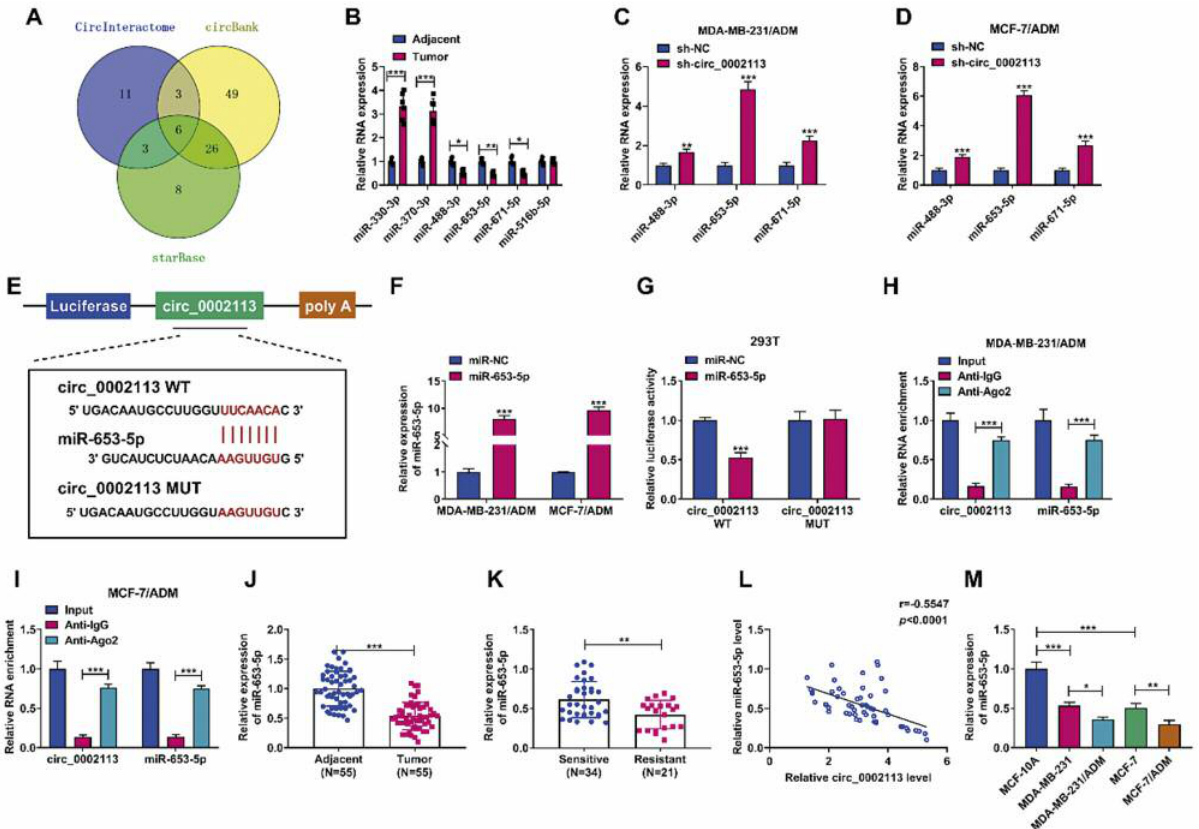
Fig. 4. Circ_0002113 interaction with miR-653-5p was a ffi rmed in BC. (A) Venn diagram analysis of miRNA targets for circ_0002113 from circinteractome, circBank and starBase. (B) The levels of miR-330-3p, miR-370-3p, miR-488-3p, miR-653-5p, miR-671-5p, miR- 516b-5p in BC tissues were detected by RT-qPCR. (C) The level analysis of miR-488-3p, miR-653-5p and miR-671-5p was conducted by RT-qPCR after transfection of sh-NC or sh-circ_0002113. (E) Circ_0002113 with miR-653-5p binding sites in circinteractome. (F) Overexpression e ffi ciency of miR-653-5p was evaluated using RT-qPCR in MDA-MB-231/ADM and MCF-7/ADM cells. (G-I) Dual- luciferase reporter assay (G) and RIP assay (H-I) were performed to analyze the binding between circ_0002113 and miR-653-5p. (J- K) The level of miR-653-5p by RT-qPCR in BC/normal tissues (J) and ADM-sensitive/resistant BC tissues (K). (L) The relation between circ_0002113 and miR-653-5p by Pearson’s correlation coe ffi cient in BC tissues. (M) RT-qPCR was used to examine miR-653-5p ex- pression in MDA-MB-231/ADM, MCF-7/ADM cells and parental/normal controls. * p < 0.05, ** p < 0.01, *** p <